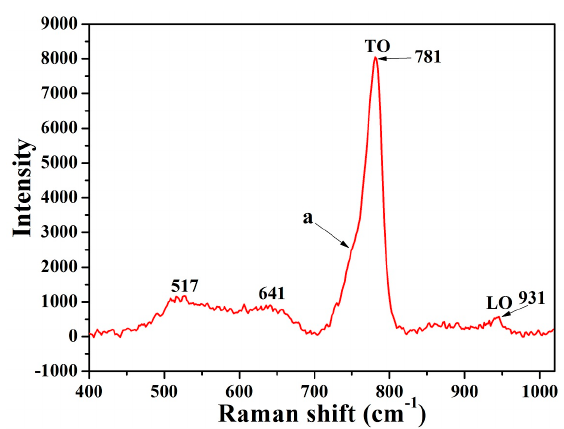
Figure 8. The Raman spectrum of D 5.